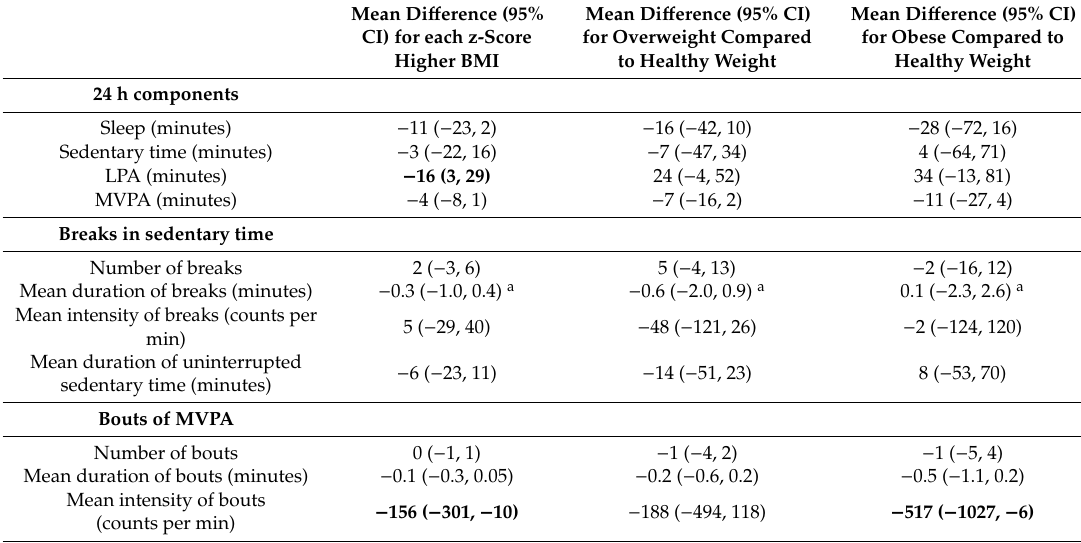
Table 1. Associations between body mass index (BMI) and di ff erent components of a 24-h day, measured in 119 New Zealand adolescent females.